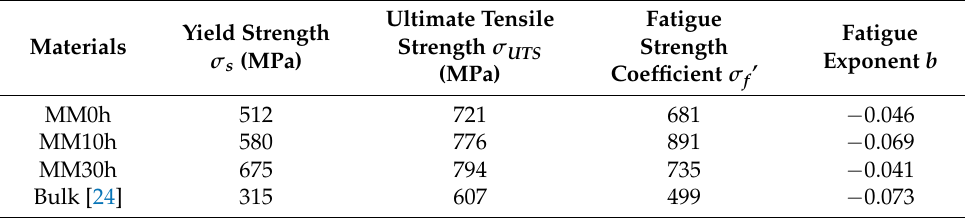
Table 4. Tensile strength and SWT parameters of harmonic-structured SUS316L steels.